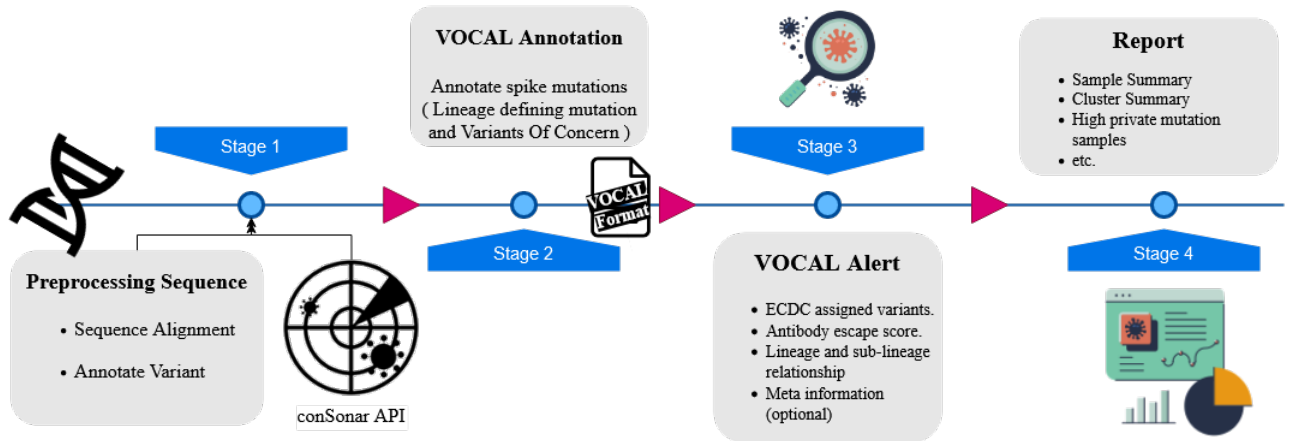
Figure 1. Main steps of the VOCAL pipeline. To generate mutation profiles for the spike gene for each input sequence, VOCAL can preprocess raw genome sequences or can directly receive this information from the